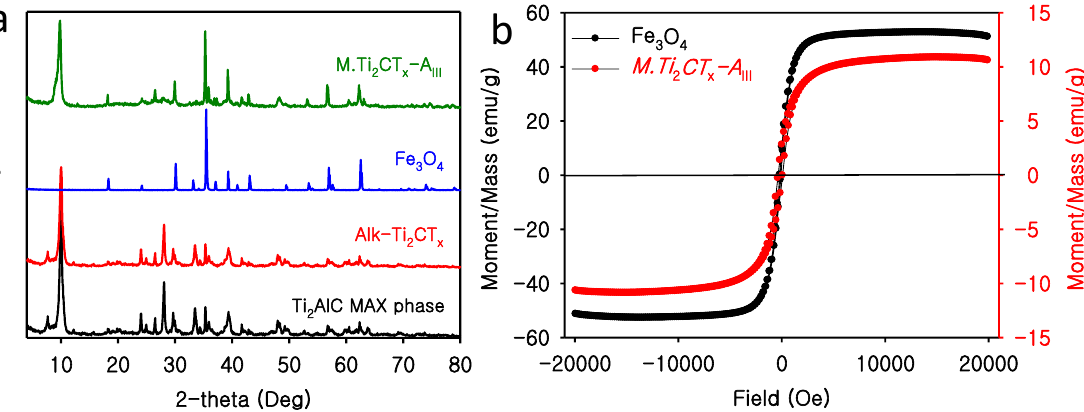
Figure 2. ( a ) XRD diffraction pattern of different phases of the fabricated materials and ( b ) magnetic field-dependent magnetization curves of M.Ti 2 CT x -A III along with that of the Fe 3 O 4 reference. The Brunauer–Emmett–Teller (BET) surface area of Ti 2 AlC MAX phase and M.Ti 2 CT x - A III were measured, and the results showed a sudden increase in the surface area from 0.618 to 29.33 m 2 /g for the parent MAX phase and M.Ti 2 CT x -A III composite, respectively